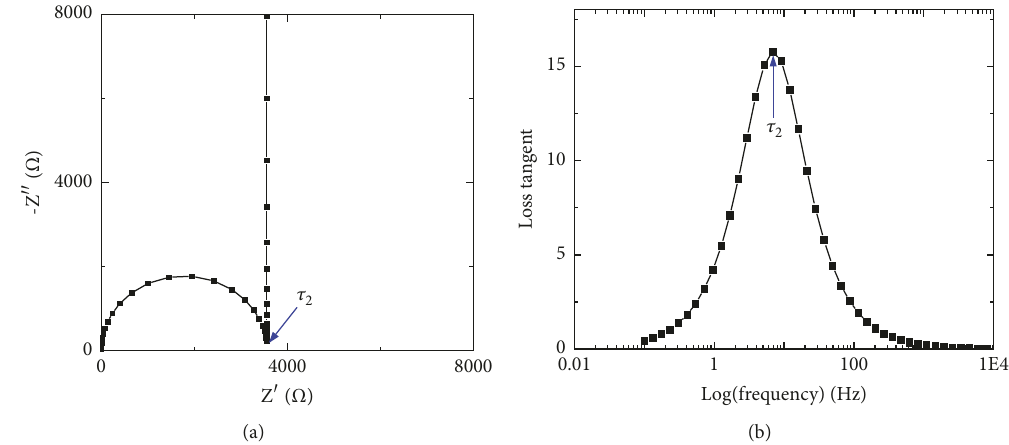
Figure 1: (a) Nyquist and (b) loss tangent plots for a general equivalent circuit of a sample in between two blocking electrodes.